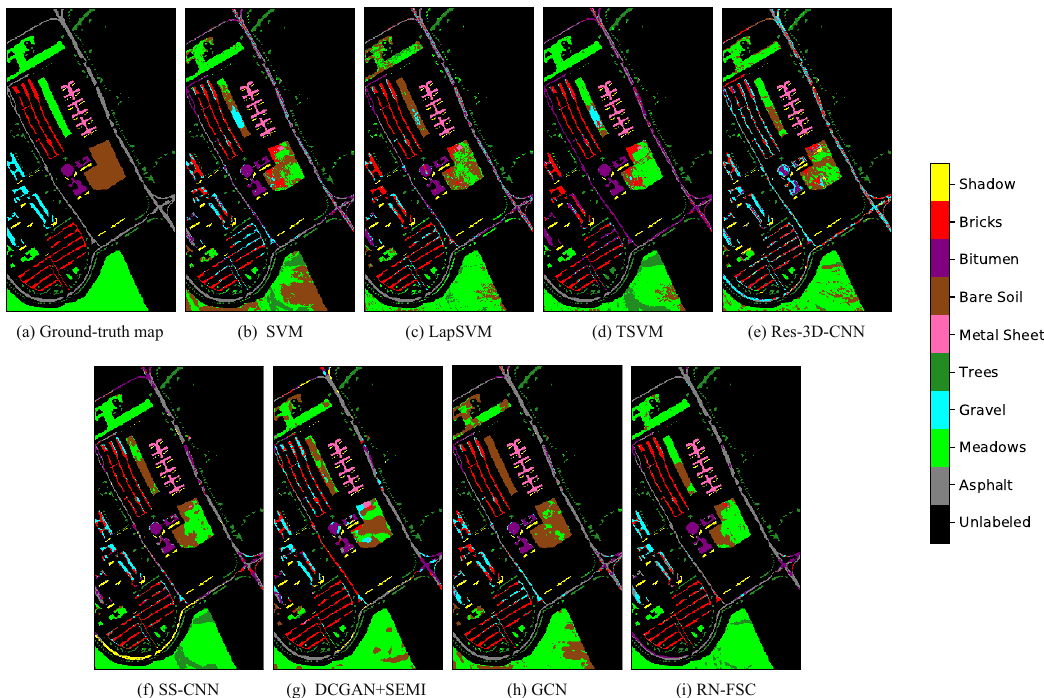
Figure 12. Classification maps resulting from different methods on the UP data